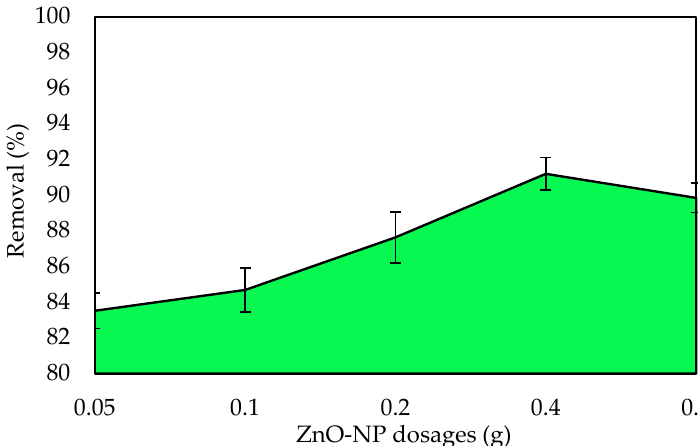
Figure 5. Influence of the ZnO ‐ NP dose on the removal of IV2R.